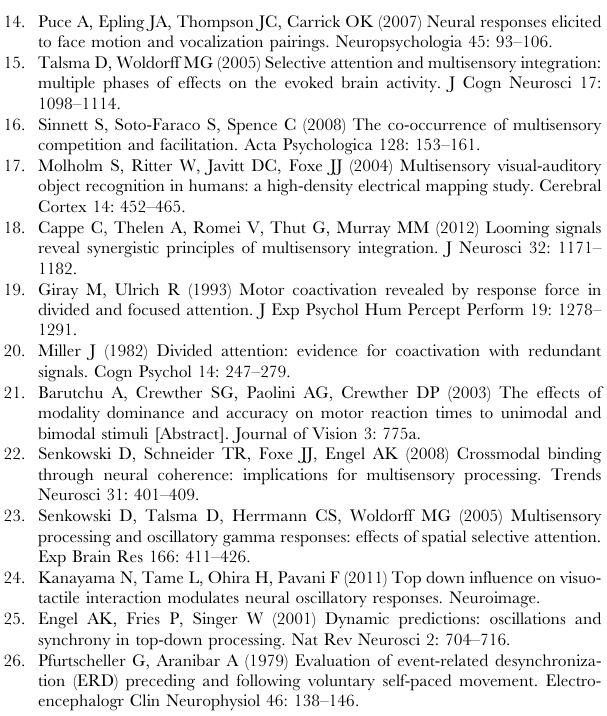
Figure S1 Event-related potentials (ERPs) for irrelevant audiovisual stimuli. A . ERPs for the audiovisual irrelevant